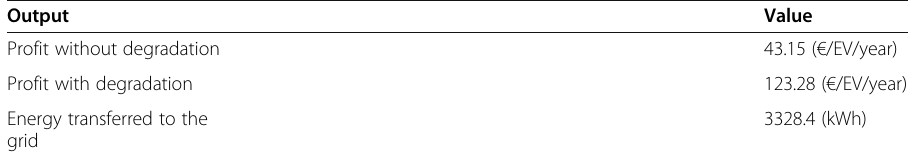
Table 5 Annual profit evaluation with EV providing V2G energy arbitrage every day in 2019